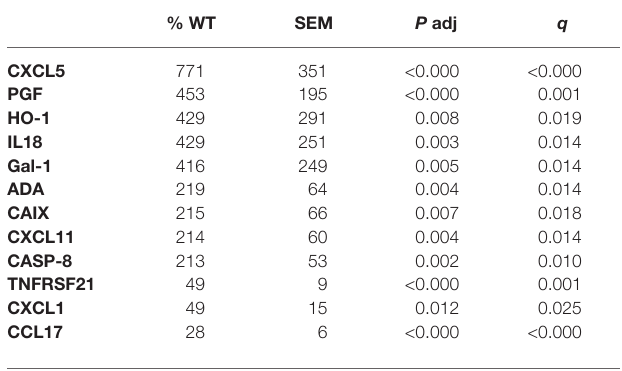
TABLE 2 | Shedding of cytokines and growth factors by primary CF epithelial cells compared to non-CF. % WT